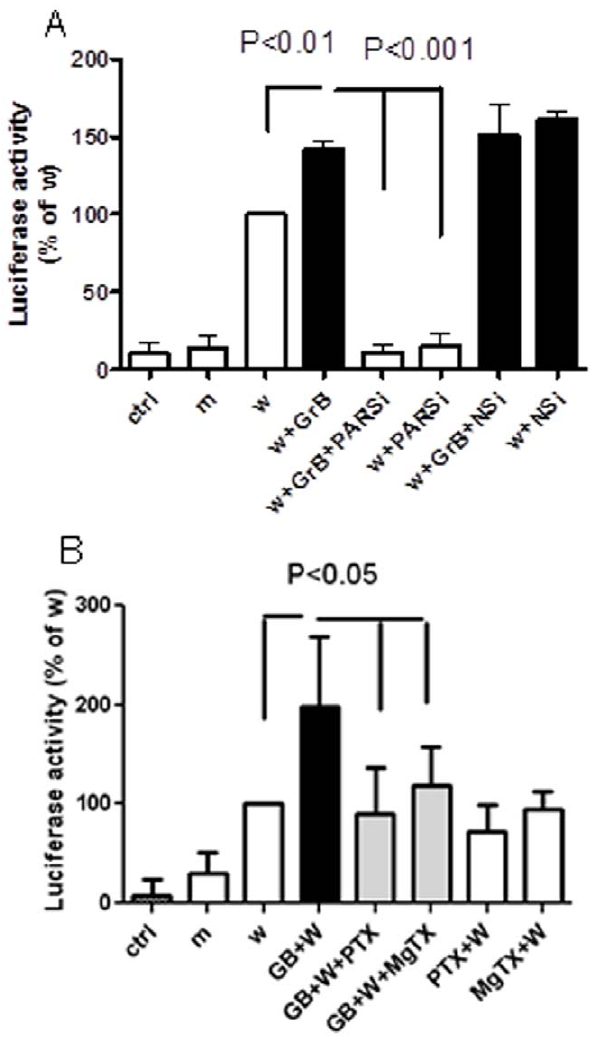
Figure 5. Notch-1 pathway activation by GrB is mediated by PAR-1 and Kv1.3. Confluent HEK293 cells were transfected with wild